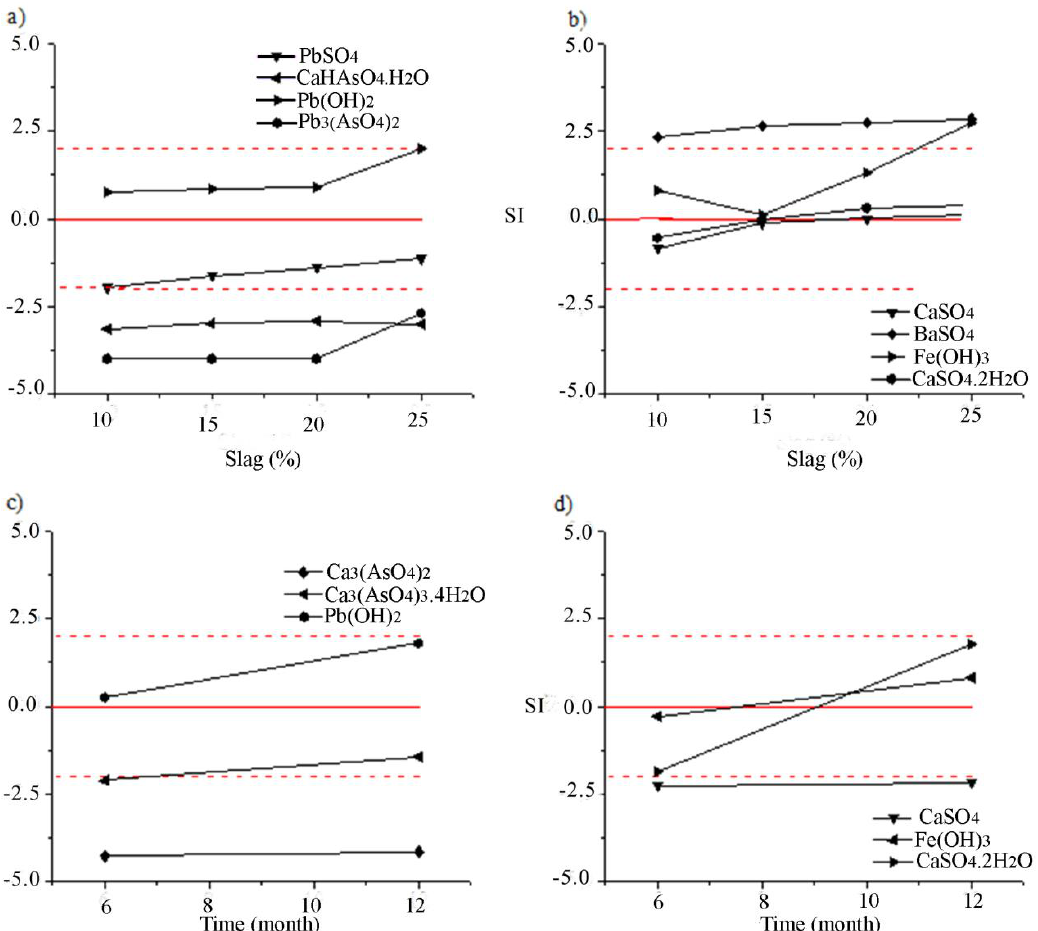
Figure 3. Saturation indices of minerals: ( a ) PbSO 4 , CaHAsO 4 · H 2 O, Pb(OH) 2 , Pb 3 (AsO 4 ) 2 and ( b ) CaSO 4 , BaSO 4 , Fe(OH) 3 , CaSO 4 · 2H 2 O as a function of slag content into solidified samples (TCLP test); ( c ) Ca 3 (AsO 4 ) 2 , Ca 3 (AsO 4 ) 3 · 4H 2 O, Pb(OH) 2 and ( d ) CaSO 4 , Fe(OH) 3 , CaSO 4 · 2H 2 O as a function of time (LEC test).